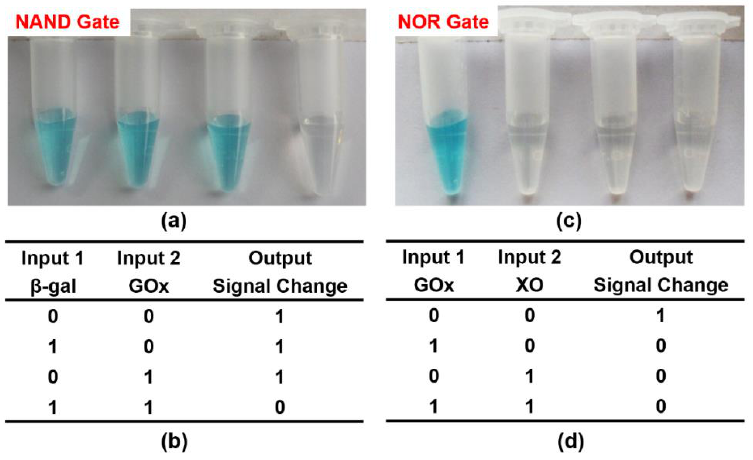
Molecules 2021 , 26 , x FOR PEER REVIEW Figure 5. The operation of logic gates based on enzymatic reactions. Figure 5. The operation of logic gates based on enzymatic reactions.